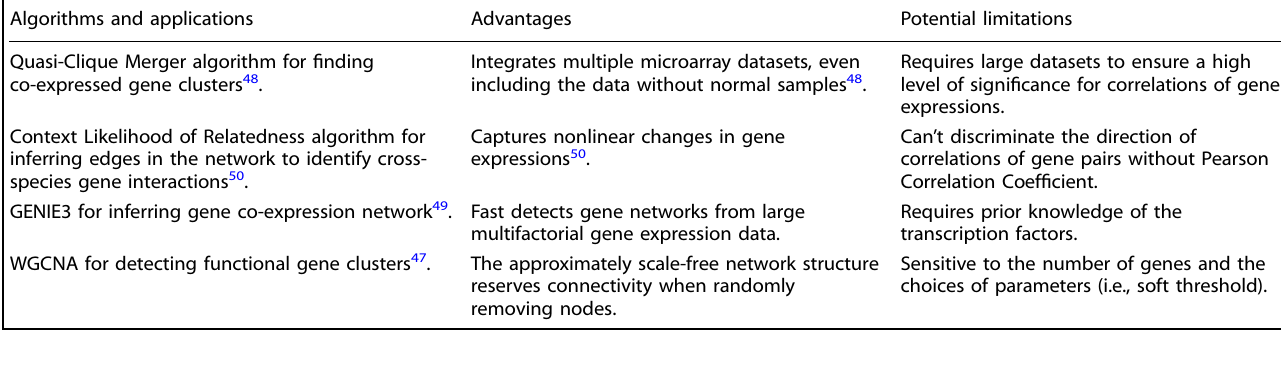
Table 1. Methods for constructing gene co-expression networks. Algorithms and applications Advantages Potential